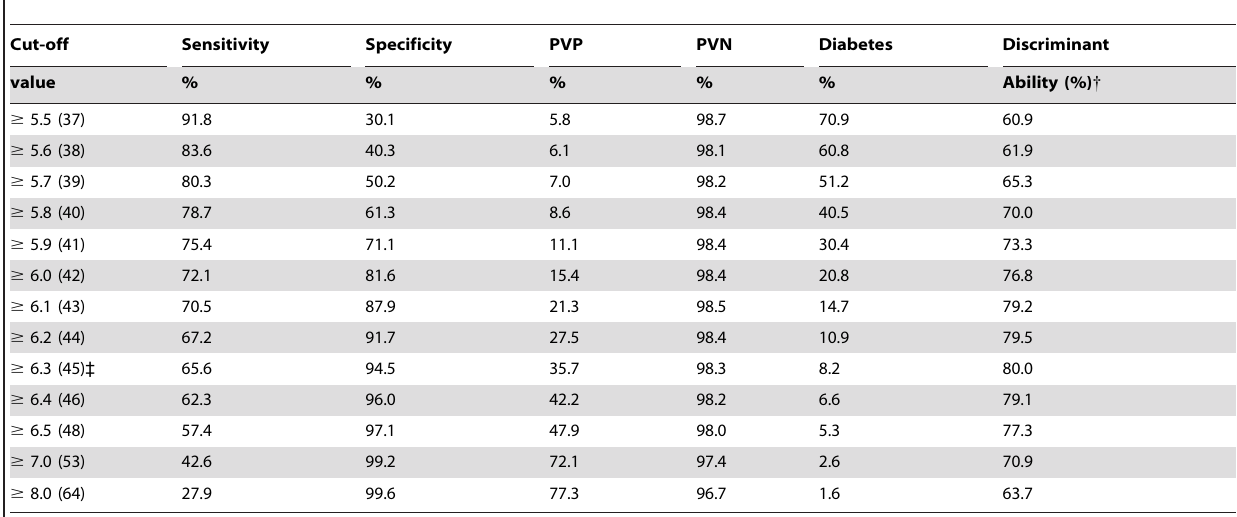
Table 1. The effect of different cut-off values of HbA 1c on sensitivity, specificity, PVP, PVN, percent of diabetes and area under ROC curves using FPG to diagnose diabetes (cut-off value $ 126